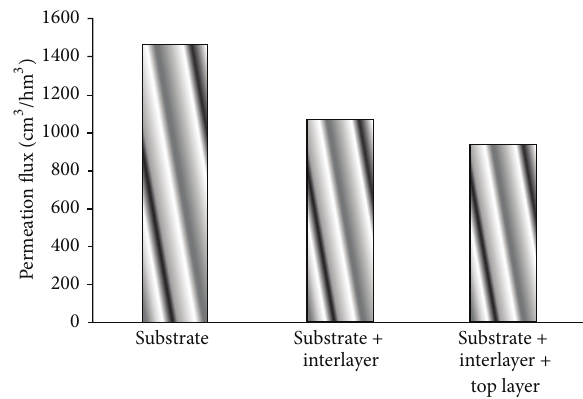
Figure 18: Permeation flux in the presence of substrate, substrate + interlayer and substrate + interlayer +